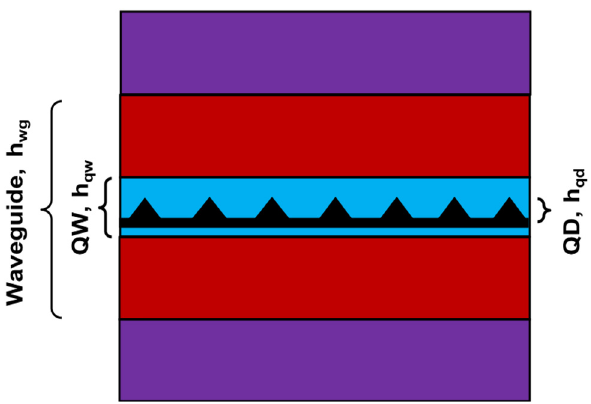
Figure 6: Sketch of QD gain region for illustrating the difference in confinement factor between free-carrier and many-body theories. Between the cladding layers (purple) defining the waveguide are QDs and wetting layer (black) embedded in a QW (blue), which is sandwiched by barriers